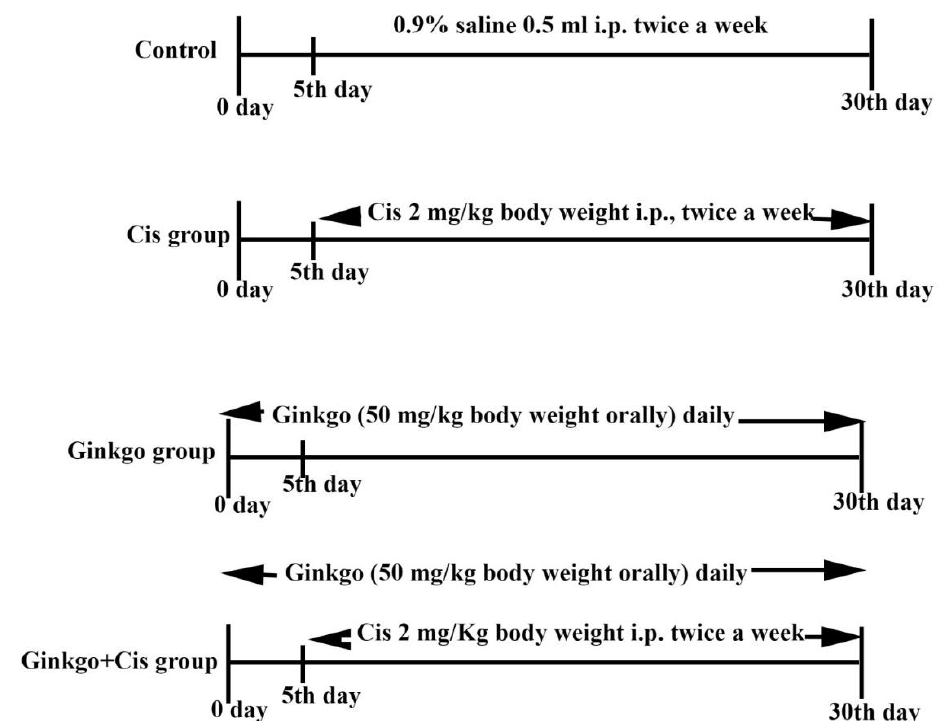
Figure 1. Experimental design including all treated groups. Experimental design outlining the cisplatin (Cis) induced cerebral damage model and Ginkgo treatment protocol where n = 10 rats for each group. Control group: Rats were injected with 0.9% saline 0.5 mL i.p. twice a week on the 5th day, for 30